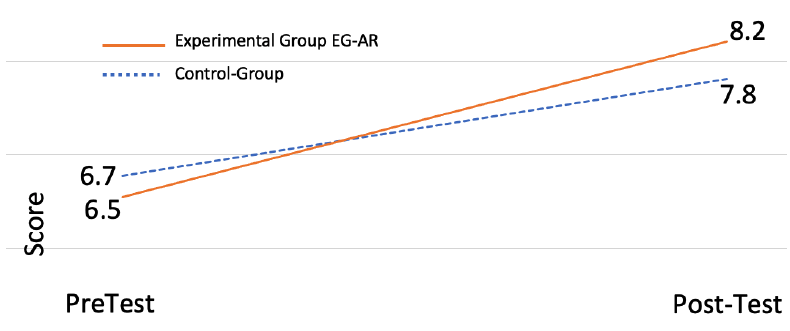
Figure 14. Knowledge improvement measurement.